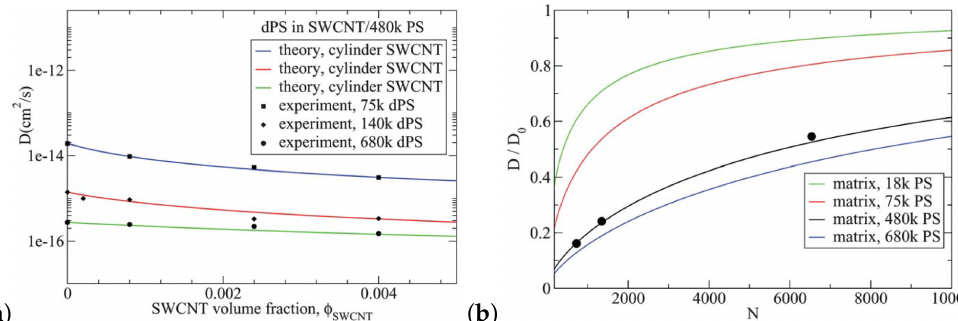
Figure 16. ( a ) Diffusivity of tracer of different molecular weights in an entangled matrix (480 kDa PS) as a function of the SWCNT volume fraction [214] in a PS/SWCNT nanocomposite system: (i) theoretical prediction for 75 kDa dPS (blue line), (ii) 140 kDa dPS (red line), (iii) 680 kDa dPS (green line line) (iv) experimental results [69] for 75 kDa dPS (squares), (v) experimental results for 140 kDa dPS (diamonds), and (vi) experimental results for 680 kDa dPS (circles). ( b ) Normalized diffusivity of tracer in an entangled matrix as a function of the number of monomers of the entangled polymer chains at the SWCNT percolation threshold ( φ SWCNT = 0.004): (i) theoretical prediction for 18 kDa PS matrix (green line) (ii) 75 kDa PS matrix (red line) (iii) 480 kDa PS matrix (black line) (iv) 680 kDa PS matrix (blue line) (v) experimental results for PS/SWCNT system in 480 kDa PS matrix at φ SWCNT = 0.004 (symbols) [69]. Reproduced from [214] with permission from the Royal Society of Chemistry.